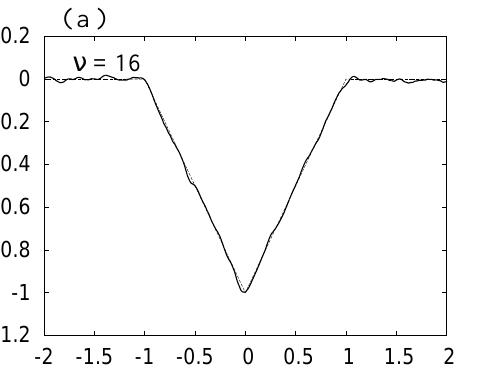
f ) ′ ( x ) and ( M ν 1 f ) ′ ( x ) ν 1